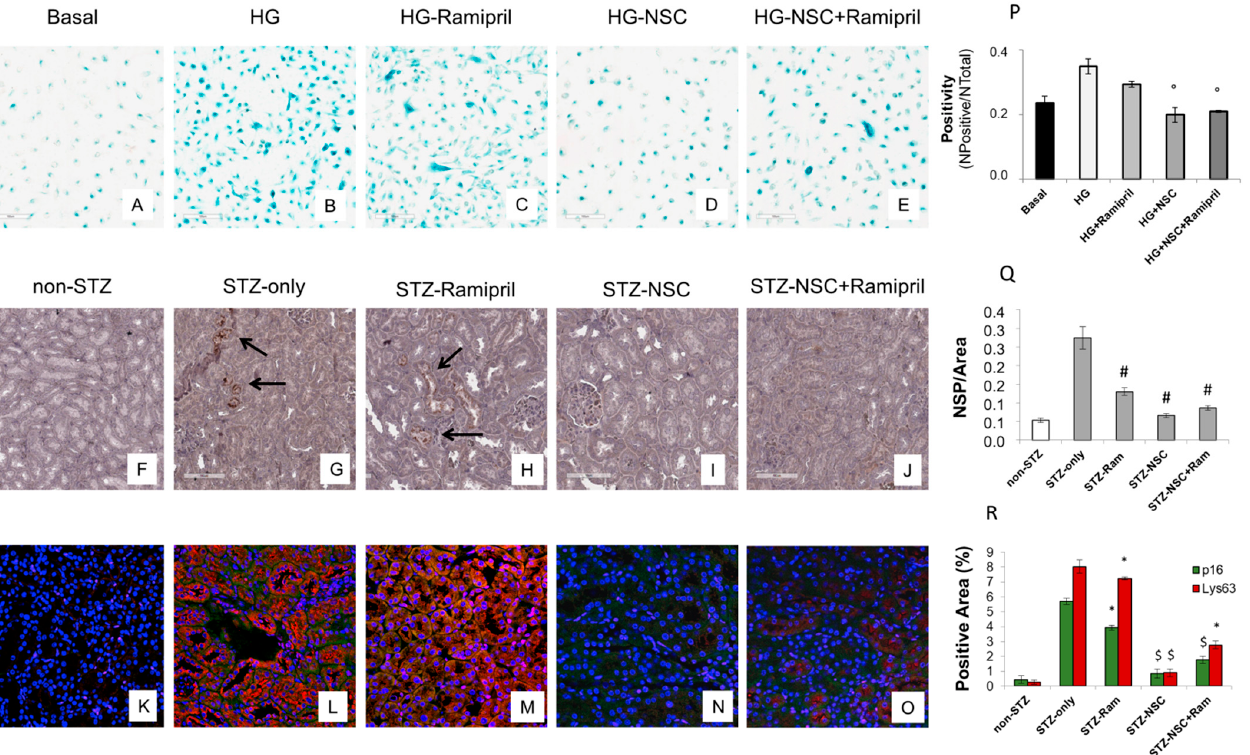
Figure 5. Treatment with NSC697923 modulated cellular senescence and renal expression of p16 INK4A in vitro in RPTEC cells and in vivo in DBA/2J mice. ( A – E , P ) SA- β Gal staining was obtained as described in the Methods in RTEC under basal conditions, exposed to high glucose (HG), and treated with ramipril, NSC697923 (NSC), or both. The ratio of cells positive for SA- β -gal activity was calculated by examining five not overlapping fields per condition. The results are presented as the mean ± SD of three independent experiments. ( F – O , Q , R ) P16 INK4A was measured using both immunoperoxidase staining ( A – E , K ) and immunofluorescence ( F – J , L ) in renal formalin-fixed paraffin-embedded section of non-diabetic animals (non-STZ), untreated diabetic animals (STZ-only), diabetic animals treated with ramipril (STZ-Ramipril), diabetic animals treated with NSC697923 (STZ-NSC), and diabetic animals treated with both ramipril and NSC697923 (STZ-NSC + Ramipril). At least four mice per group were used. The lower panel shows immunofluorescence of p16 INK4A in the green channel and K63-ubiquitinated proteins in the red channel. Figure magnification 63X. The immunoperoxidase staining was quantified as the number of strong positives (NPS) on the area analyzed; P16 INK4A and K63-ubiquitinated protein expression in immunofluorescence was quantified as a percentage of the positive area on the area analyzed. Histograms are indicative of mean values while error bars are indicative of the standard deviation. ◦ p < 0.05 vs. HG; * p < 0.05 vs. STZ only; $ p < 0.005 vs. STZ only; # p < 0.0005 vs. STZ